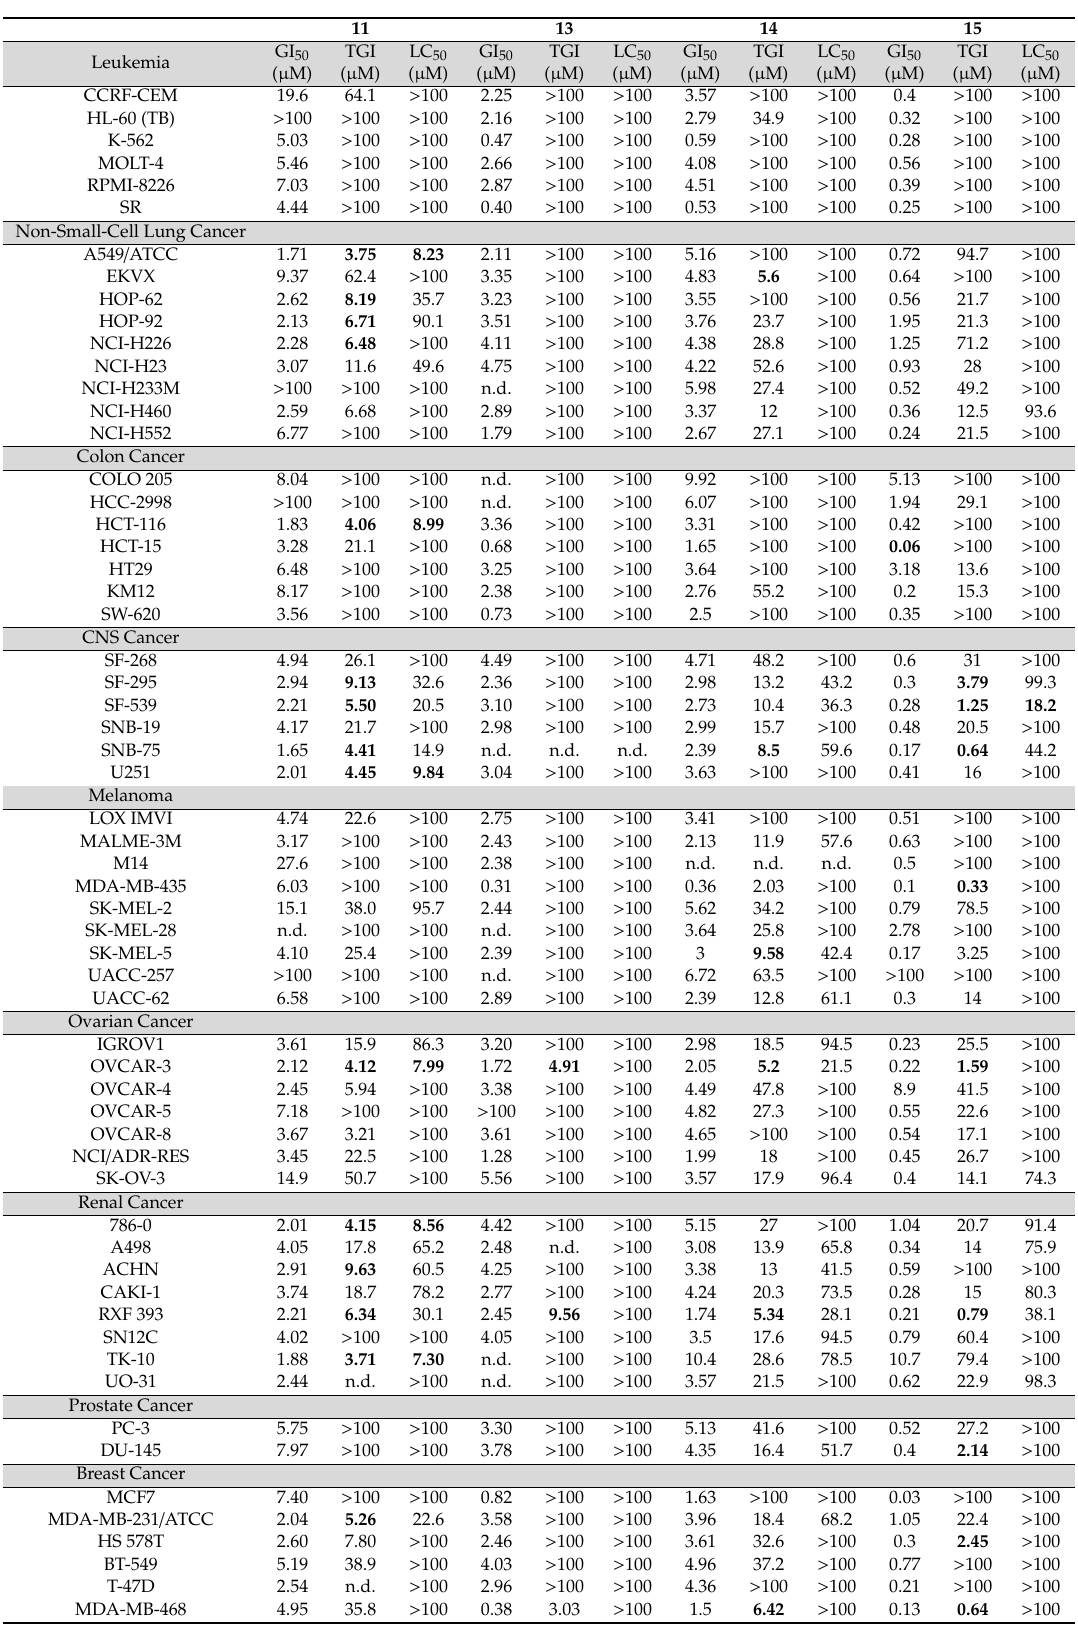
Table 4. Cytotoxic activities (GI 50 , TGI and LC 50 ) of compounds 11 , 13 , 14 , and 15 against 60 human cancer cell lines in vitro. Values where GI 50 < 100 nM or TGI / LC 50 < 10 µ M are highlighted in